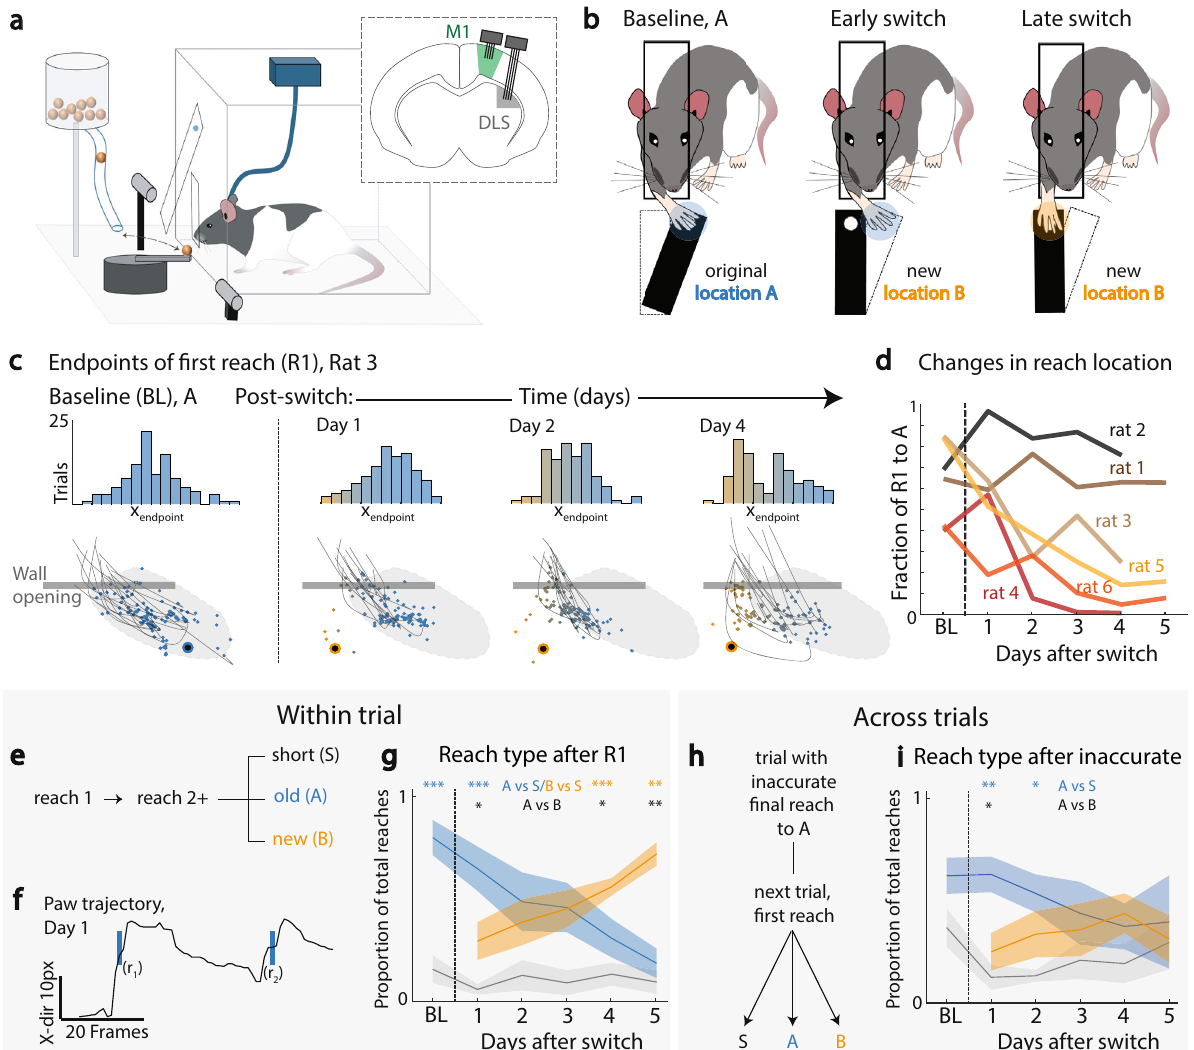
Fig. 1 Multiday relearning of an automatic skill. a Automated reach-to-grasp setup. After the door opens (signaled by a tone), the rat reaches through a slit to retrieve the pellet. M1 (green) and DLS (gray) locations in inset. b Relearning paradigm. Rats are overtrained to reach to location A (left). Then pellet moved to location B with continued training (middle, right). c Endpoint of fi rst reaches. Top: example animal, histogram of endpoint x-position, across trials. Bottom: example reach trajectories and endpoint locations relative to pellet location (large black circle) for same sessions as (top). d Decay in reaches to A. Percentage of trials in a session with fi rst reach (R1) to location A, as compared to low-amplitude (short, S) reaches and/or reaches to location B. e For those trials with multiple reaches, within-trial updating for reaches after the fi rst were classi fi ed into short (S), old (A), or new (B) reaches. f Example x-trajectory of paw during a trial, with reach onset marked; r1 and r2 are the fi rst and second reach onsets, respectively. g Reach type after fi rst reach, for trials with multiple reaches. For all reaches after the fi rst reach in a trial, proportion of A, B, or S reaches. Data are presented as mean values ± SEM. h Following an inaccurate trial, we classi fi ed the fi rst reach type of the subsequent trial . i Reach type after inaccurate reach to A on previous trial. Data are presented as mean values ± SEM. *<0.05; **<0.01; ***<0.001, ANOVA, Tukey-Kramer post hoc test. Source data are provided as a Source Data fi